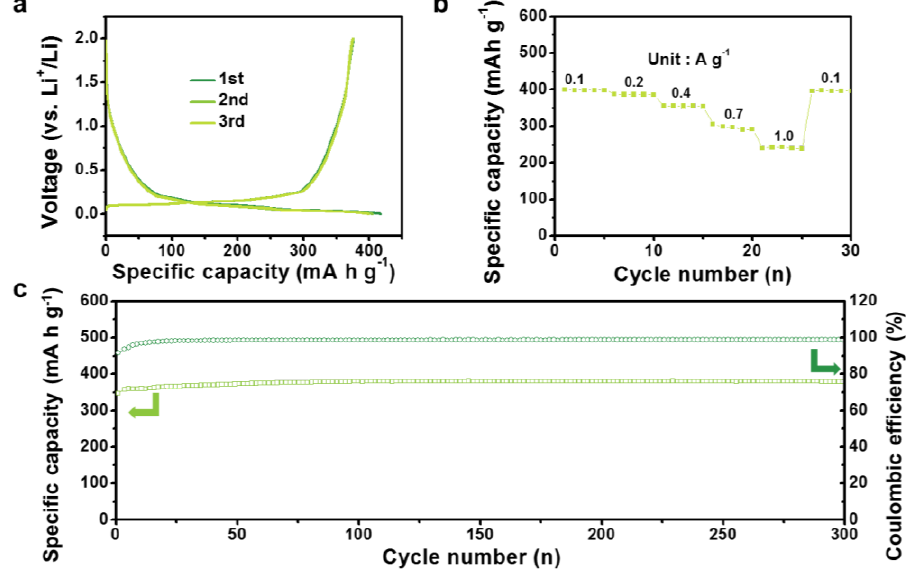
Figure 7. Electrochemical performances of GNS anode in an electrolyte of 1 M LiPF 6 dissolved in an EC/DMC mixture solution (1:1 v/v) over a voltage window of 0.01~2.0 V vs Li + /Li. ( a ) Galvanostatic discharge/charge profiles, ( b ) Rate capabilities in current densities from 0.1 to 1.0 A·g −1 , and ( c ) Cycling behaviors over 300 cycles.